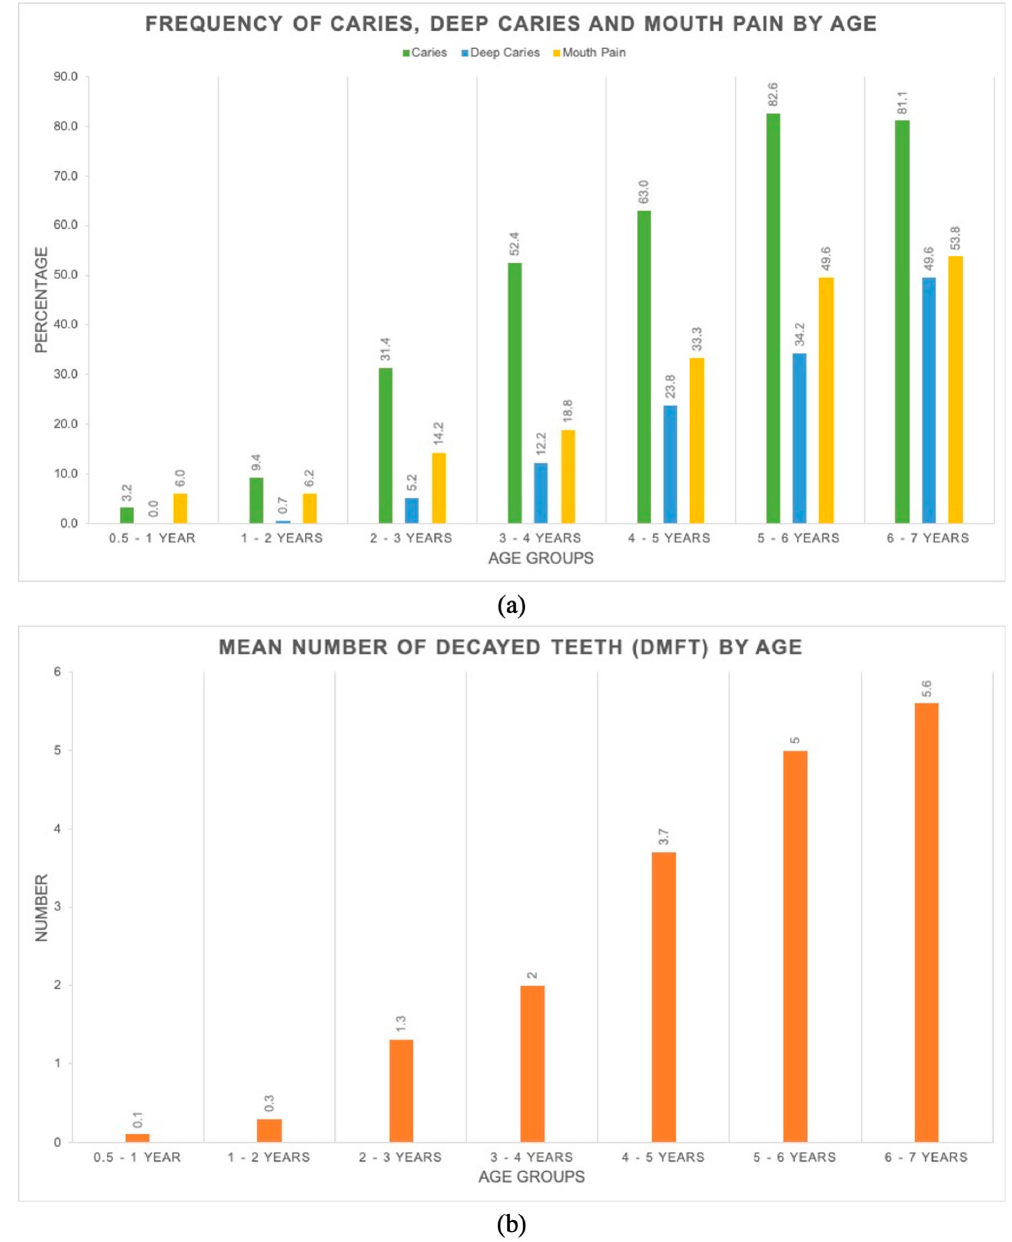
Figure 2. Child caries experience by age ( a ) Frequency of caries, deep caries and mouth pain by age; ( b ) Mean decayed, missing or filled teeth (dmft) by